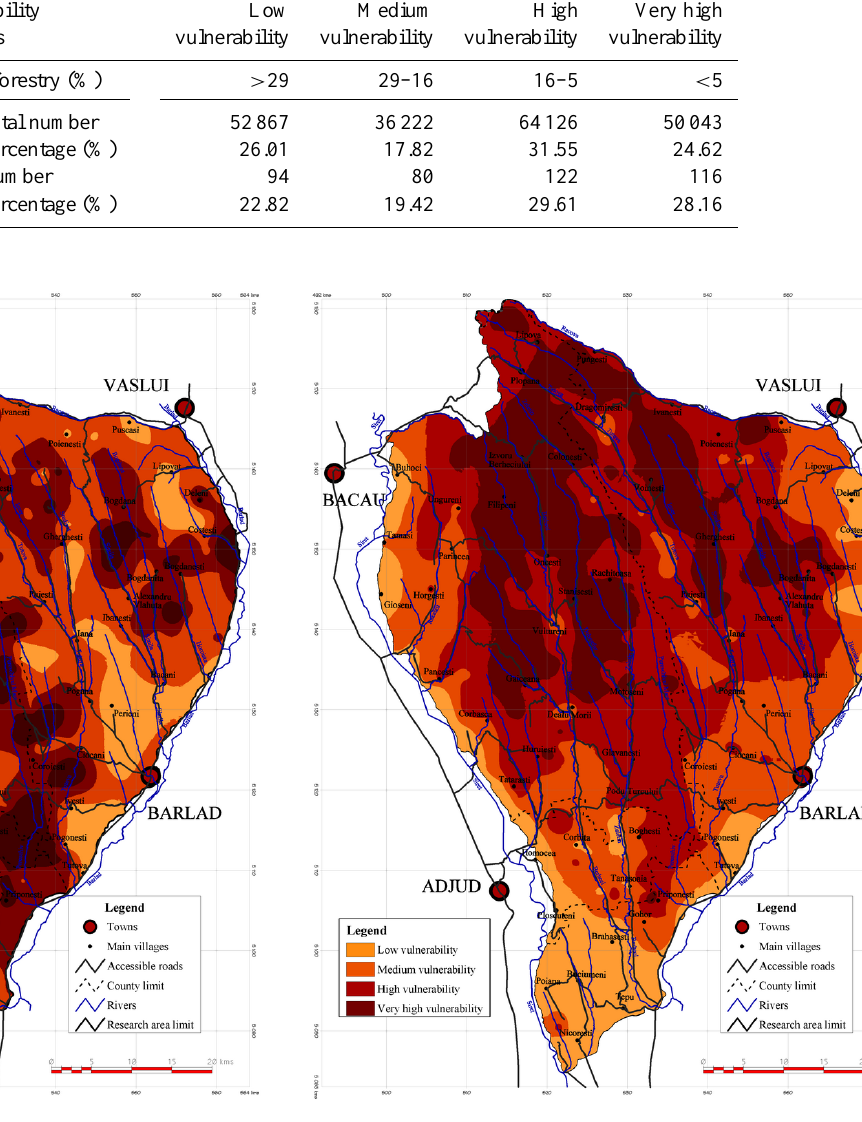
Fig. 4. Vulnerability factor 2: Population dependency ratio in Tu- tova Hills.